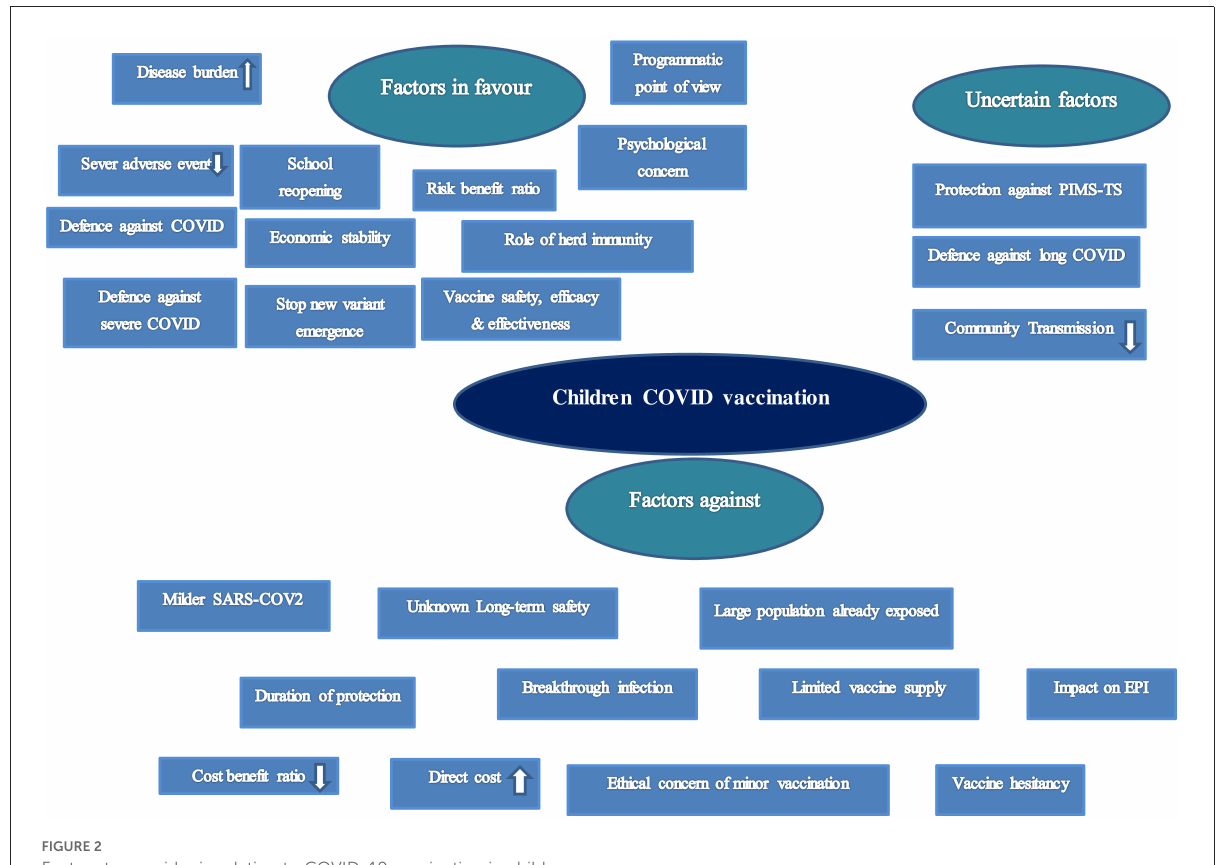
FIGURE2 Factors to consider in relation to COVID-19 vaccination in